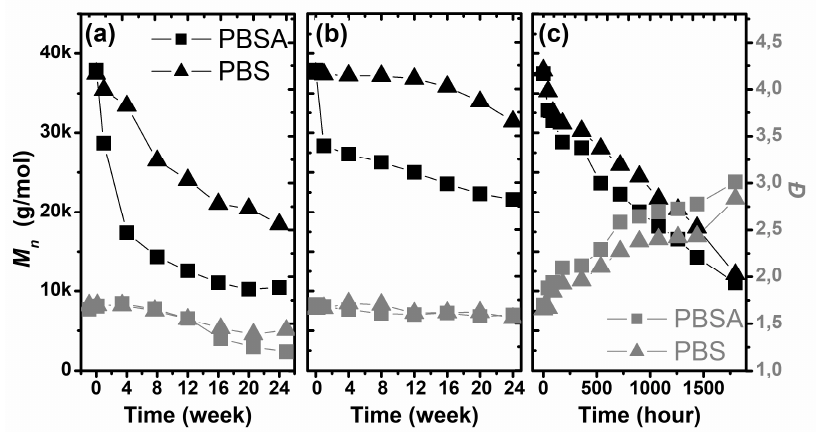
Figure 4. Changes in molar mass ( M n ) (black symbols) and dispersity (gray symbols) of the studied samples during degradation in selected environments: ( a ) biodegradation in compost, ( b ) biodegradation in soil and ( c ) artificial weathering.